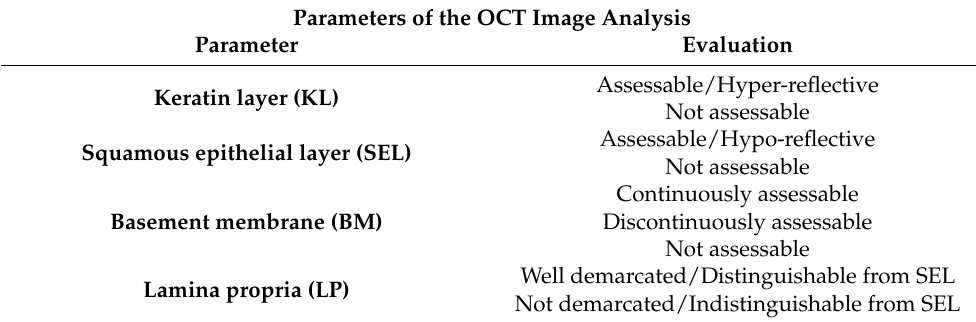
Table 1. OCT parameters for oral epithelial and subepithelial evaluations.